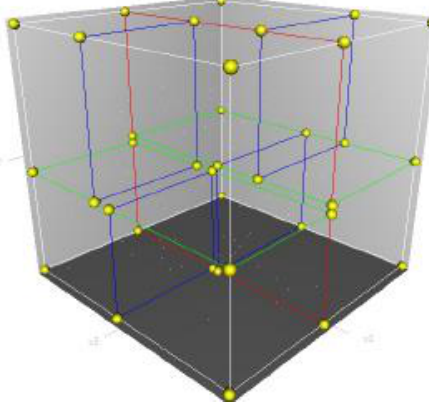
Figure 5. The KD tree subdivision in three-dimensional space.